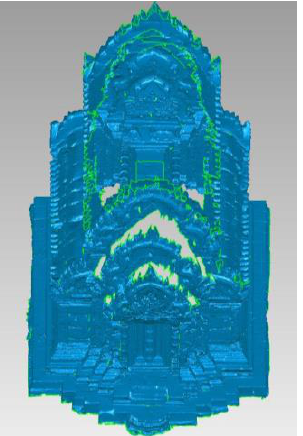
Figure 11. The triangular mesh generated from TLS data